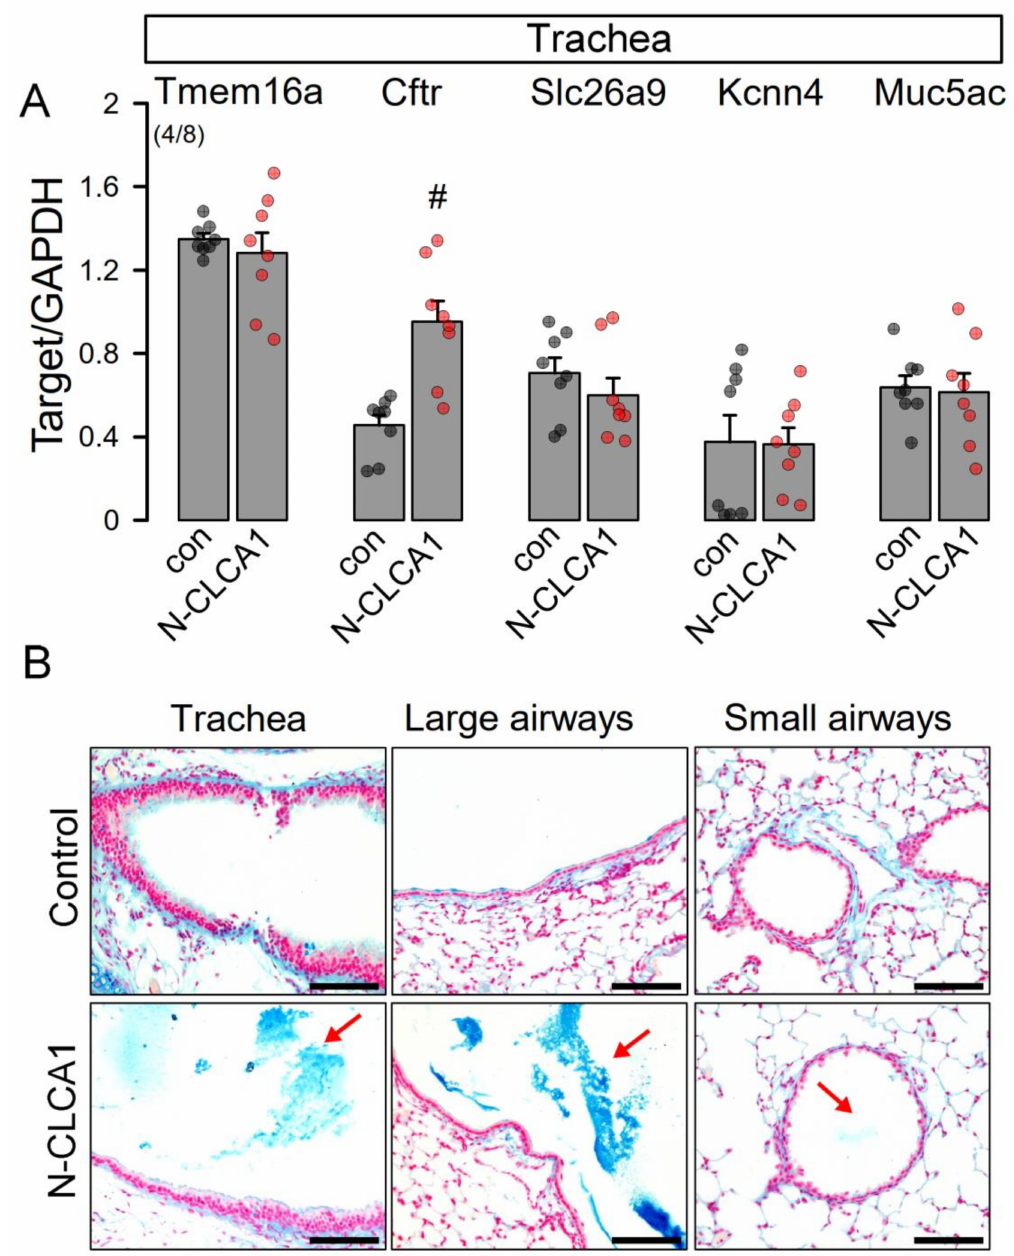
Figure 1. N-CLCA1 increases mucus production in vivo. ( A ) Semiquantitative RT-PCR analysis of the expression of MUC5AC, TMEM16A, CFTR, SLC26A9 and KCNN4 in isolated tracheal epithelial cells from control mice and mice treated for 24 h with N-CLCA1. Mean ± SEM (number of animals/number of reactions). # —significant difference when compared to control or mock ( p < 0.05; unpaired t -test). ( B ) Alcian blue staining indicating enhanced mucus secretion in airways exposed to N-CLCA1. Bar = 100 µ